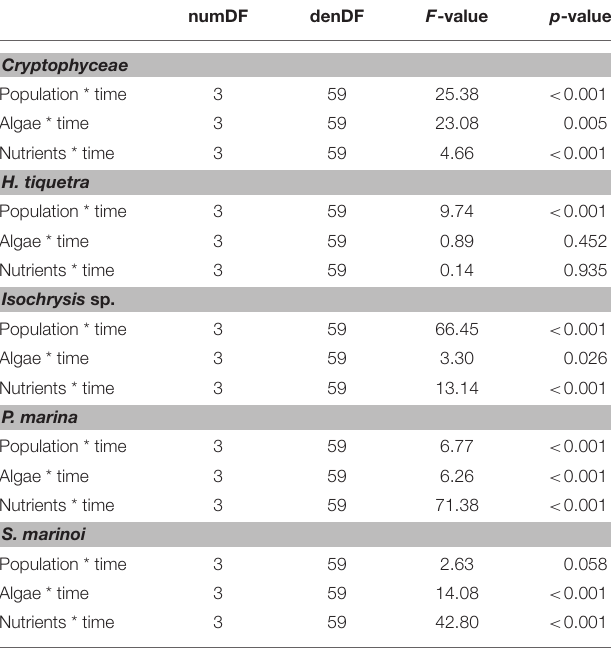
TABLE 2 | ANOVA output from the mixed models on the pelagic algae. numDF denDF F -value p -value